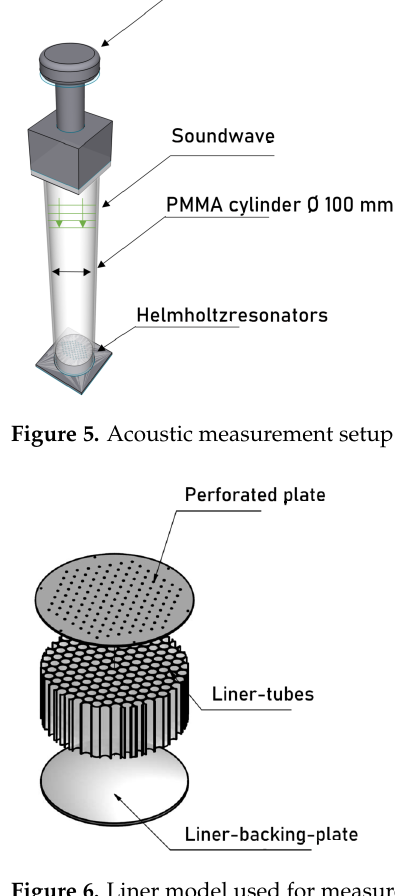
Figure 6. Liner model used for measurements, providing 169 Helmholtz